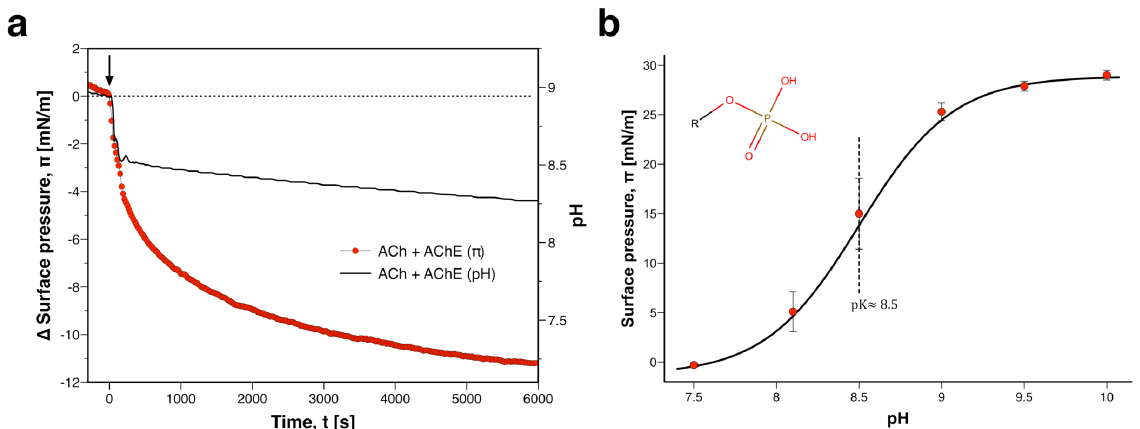
Figure 4. State change in phosphatidic acid (PA) monolayer upon injection of acetylcholine (ACh). ( a ) Change in surface pressure π (red circles, left axis) and subphase pH (line, right axis) when ACh was injected (arrow) onto a DMPA monolayer with acetylcholinesterase (AChE). ( b ) Two protons can dissociate from the phosphate head of PA. Titration with hydrochloric acid reveals strong membrane state changes around pK . The solid line represents the fit of the Boltzmann sigmoid function to HPO − 4 average data StDev of n = 3